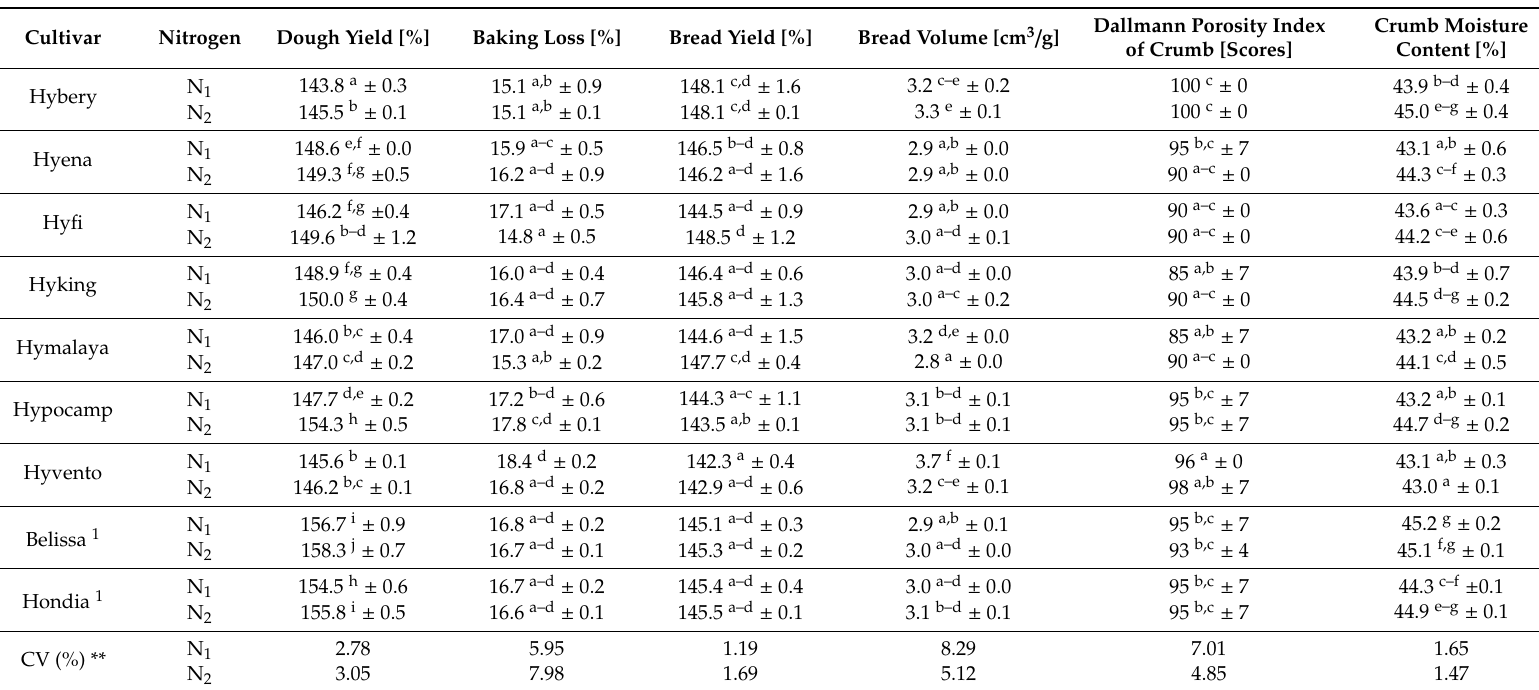
Table 4. Baking process parameters of wheat flour and quality indicators of wheat bread obtained from hybrid and population cultivars.